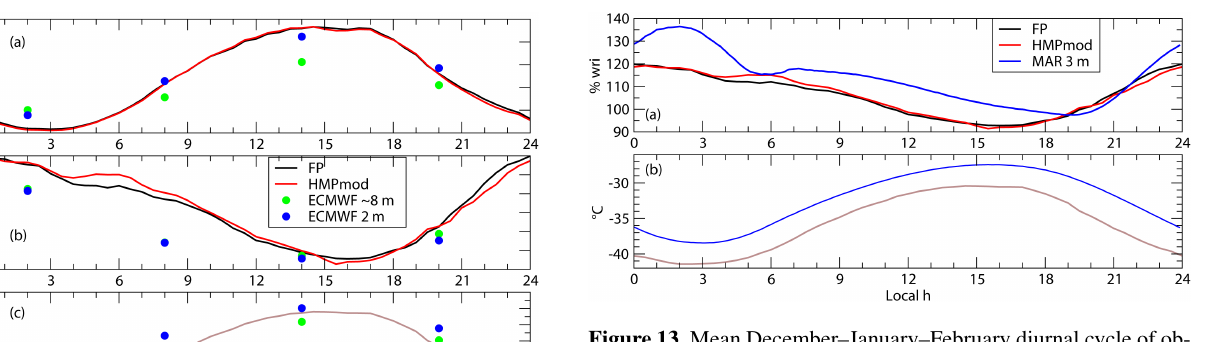
Figure 13. Mean December–January–February diurnal cycle of ob- served (FP and HMPmod for moisture, HMP for temperature) and MAR-simulated RH i (a) and air temperature (b) , the brown curve being the observed as in Fig.